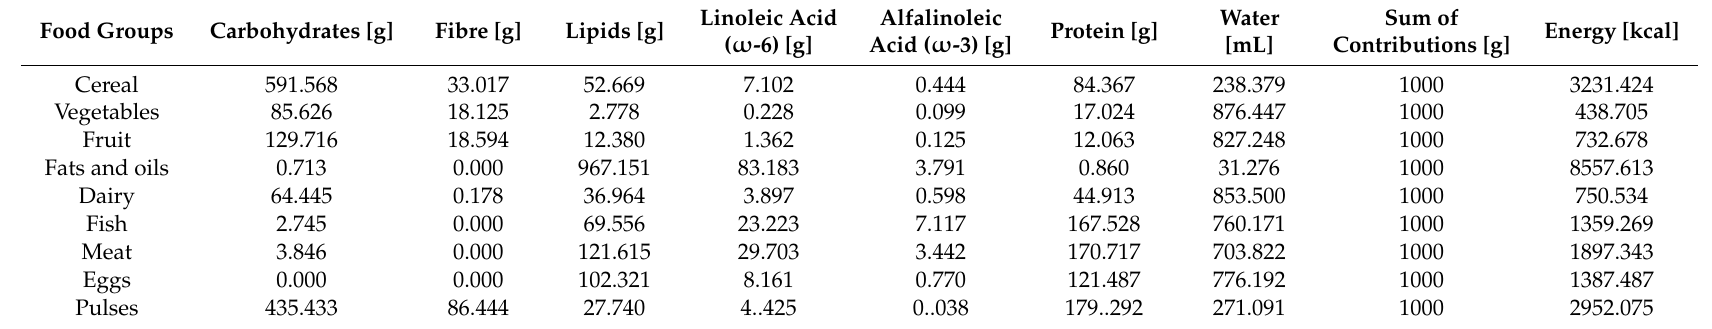
Table 3. Macro-nutritional contribution (with